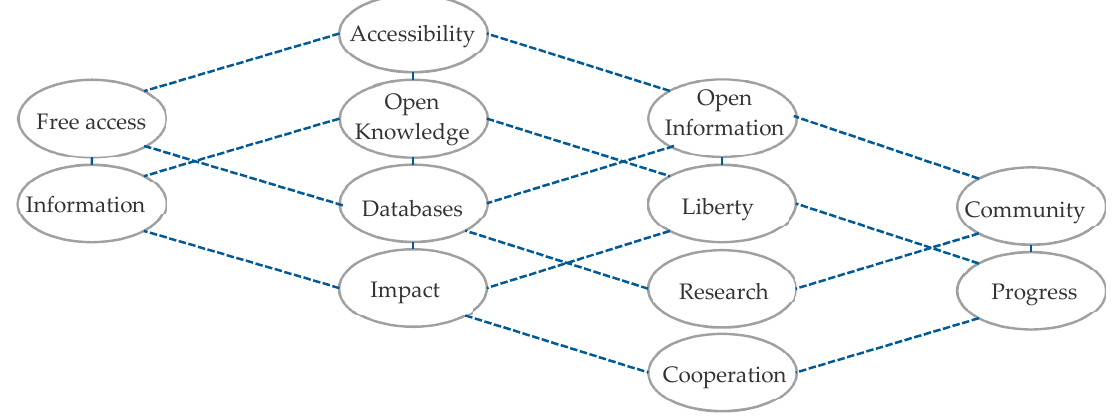
Figure 2. Words related to open science, according to Colombian researchers.